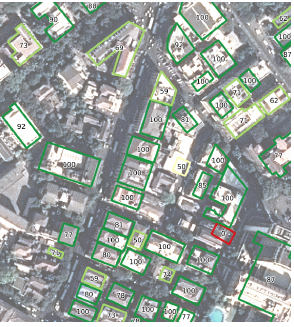
Figure 6. The tuples from the database are compared to those filtered from the line segment detection